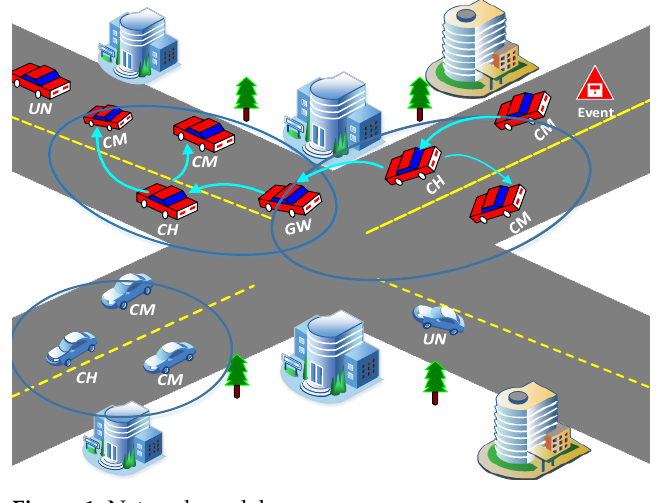
Figure 1. Network